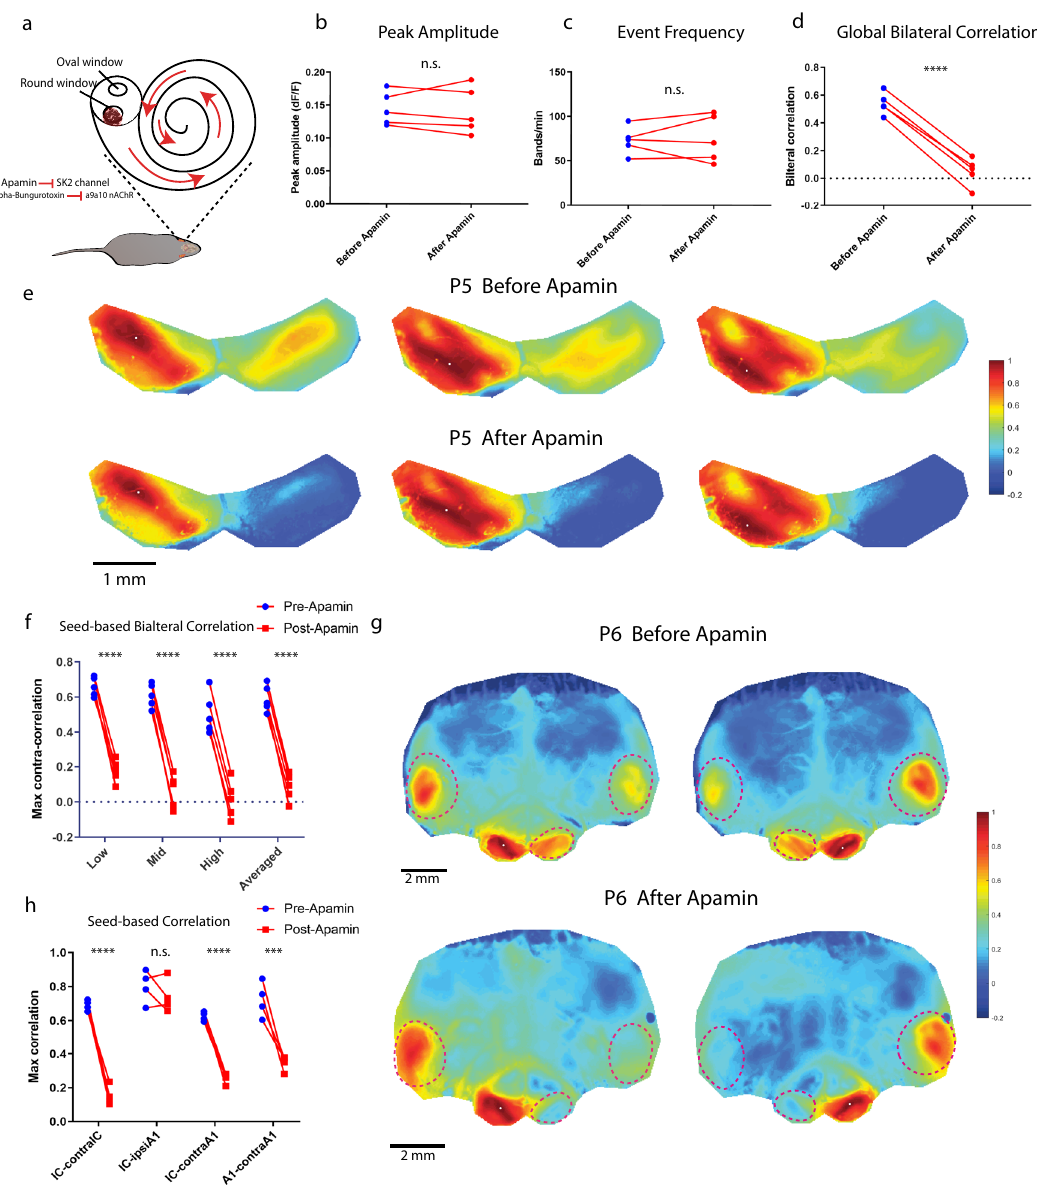
Fig. 3 Acute apamin application abolishes bilateral coupling in vivo. a Schematic showing in vivo pharmacology via delivery through the round window. b Example correlation maps showing correlation patterns in the IC before and after apamin application from the same SNAP25-G6s control animal at P5. Top panels: before apamin. Bottom panels: after apamin. Three typical representative seeds (white dots) located in the future low-, mid-, and high- frequency regions. c Average peak amplitude. Similar to Fig. 1d. d Event frequency. Similar to Fig. 1e. e Global bilateral correlation. Similar to Fig. 1j. f Seed- based bilateral correlation. Similar to Fig. 1k. b – f Number of animals (SNAP25-G6s) = 5. Scale bar denotes 1 mm. g Example correlation maps with a large fi eld of view including both midbrain and cortex before and after apamin from the same P6 SNAP25-G6s animal. Top panels: before applying apamin. Bottom panels: after applying apamin. The white dot denotes the locations of seeds. Dashed magenta lines: ROIs de fi ned to quantify maximum regional correlations. Similar to Fig. 2 h. h Seed-based correlation. IC-contralIC: Correlation between ipsilateral and contralateral IC. IC-ipsiA1: Correlation between ipsilateral IC and A1. IC-contraA1: Correlation between ipsilateral IC and contralateral A1. A1-contraA1: Correlation between ipsilateral A1 and contralateral A1. Signi fi cance marks: n.s. p > 0.05, **** p < 0.0001, two-tailed unpaired t test with Welch ’ s correction. Number of animals (SNAP25-G6s) = 4. n.s. p > 0.05, ∗